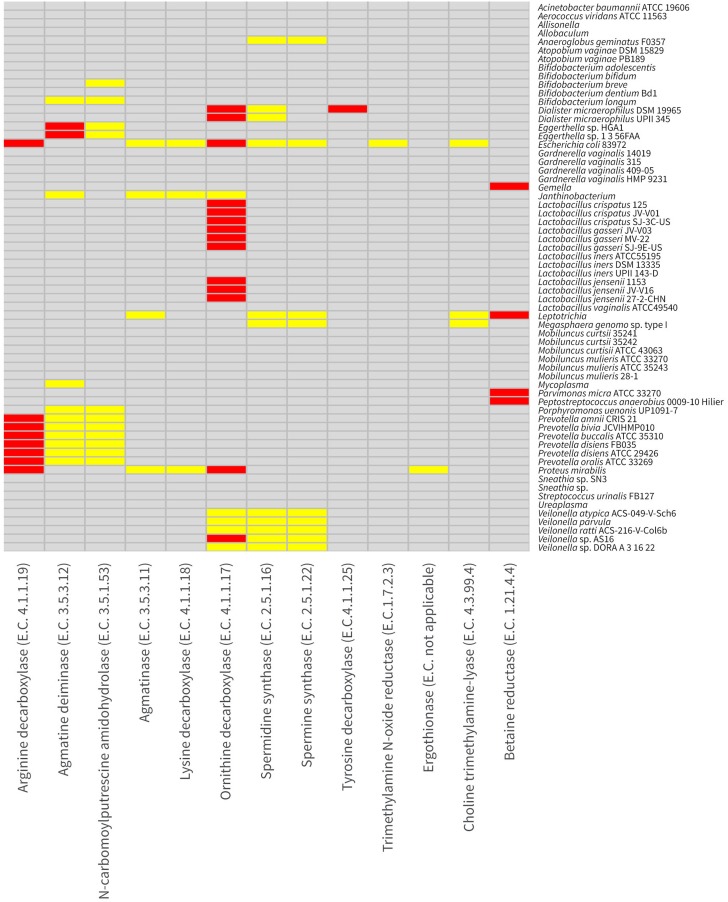
Distribution of biogenic amine-synthesizing proteins (BSPs) in vaginal taxa. The distribution of BSPs in the 65 vaginal taxa examined is presented as a heat map. Gray indicates no evidence of the BSP shown on the horizontal axis in the taxon shown on the vertical axis. Yellow indicates a strong alignment to a characterized homolog or to a corresponding hidden markov model (HMM), while red indicates both a strong alignment to a characterized homolog and a corresponding HMM. Enzyme numbers (E.C.) are shown with BSPs.